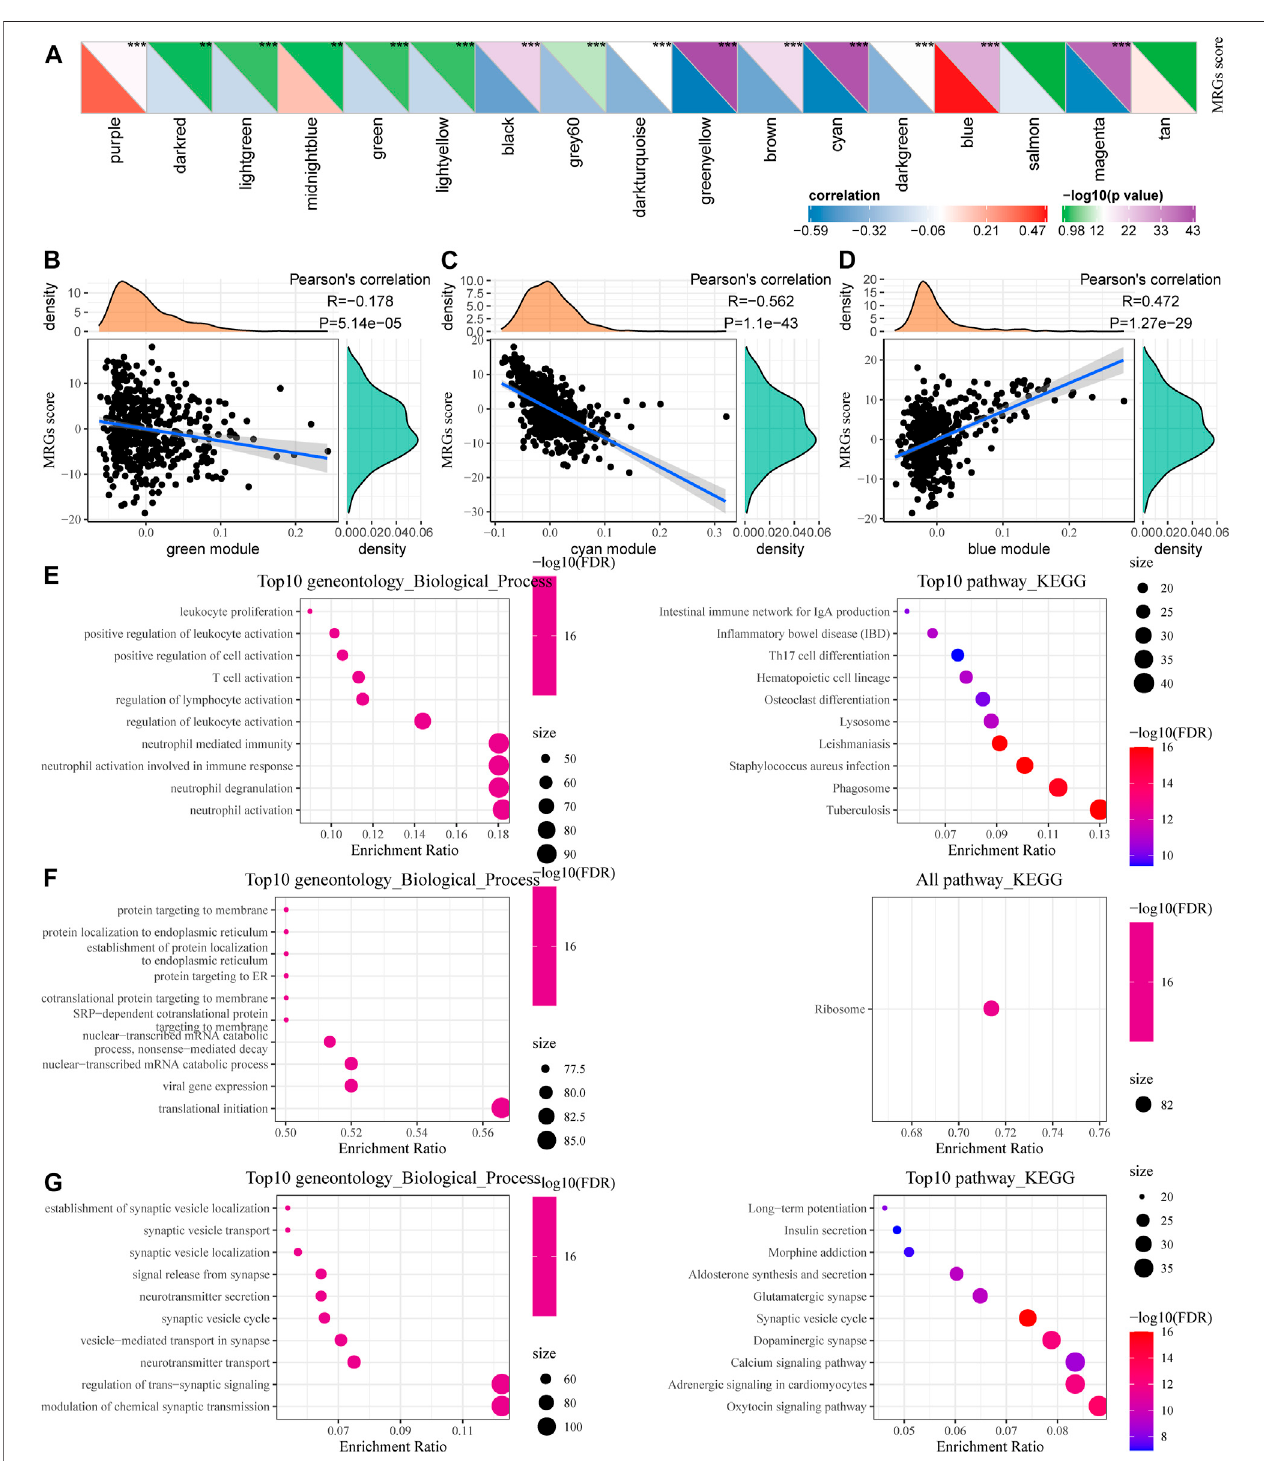
FIGURE 7 | Functional enrichment analysis of metabolic co-expression gene module. (A) Correlation analysis between module feature vector and metabolic subtypefeatureindex. (B) Thecorrelationbetweenthefeaturevectorofthegreenmoduleandthefeatureindexofmetabolicsubtypes. (C) Correlationbetweenthecyan module and the feature index of metabolic subtypes. (D) Correlation between the blue module feature vector and the metabolic subtype feature index. (E – G) Functional enrichment analysis results for green, cyan, and blue modules.